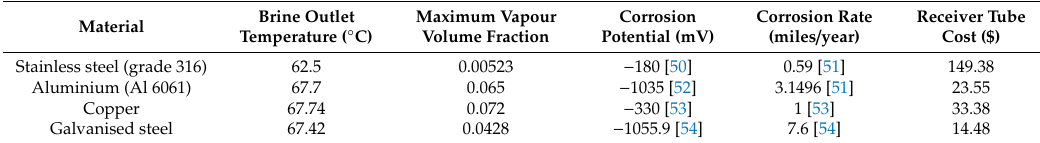
Table 5. Comparative analysis between marine grade metals to construct the receiver tube according to the thermal performance, corrosivity, and cost.